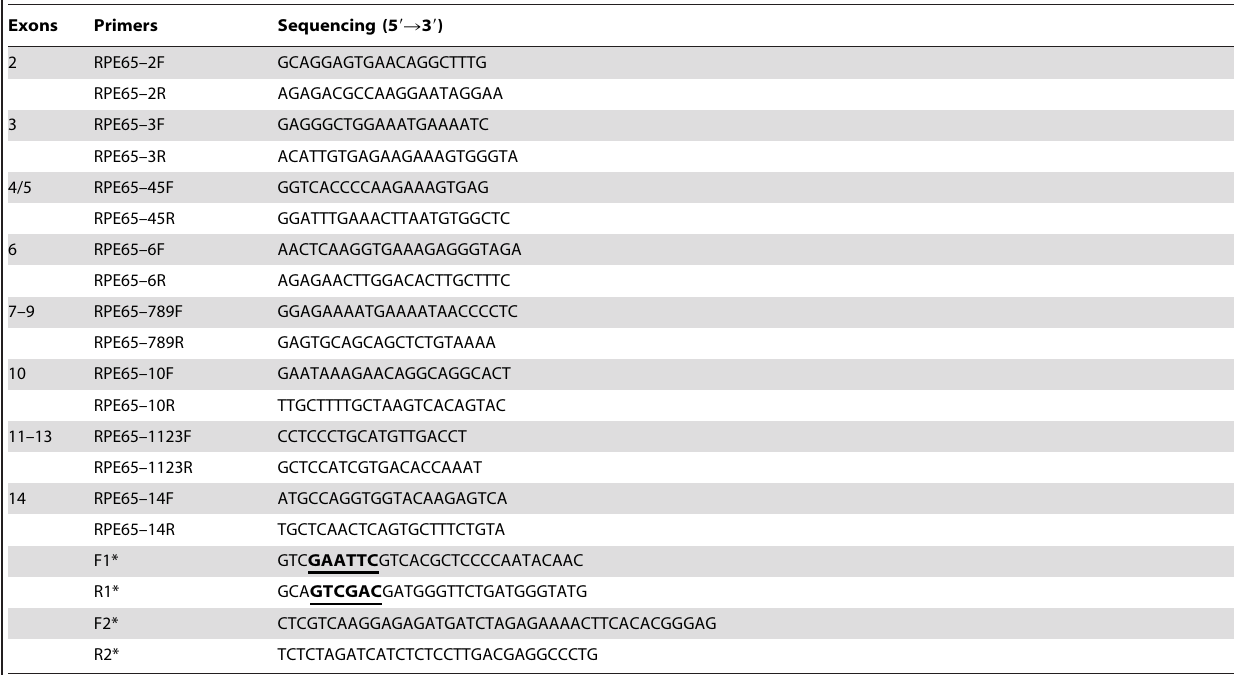
Table 1. Primers used in the